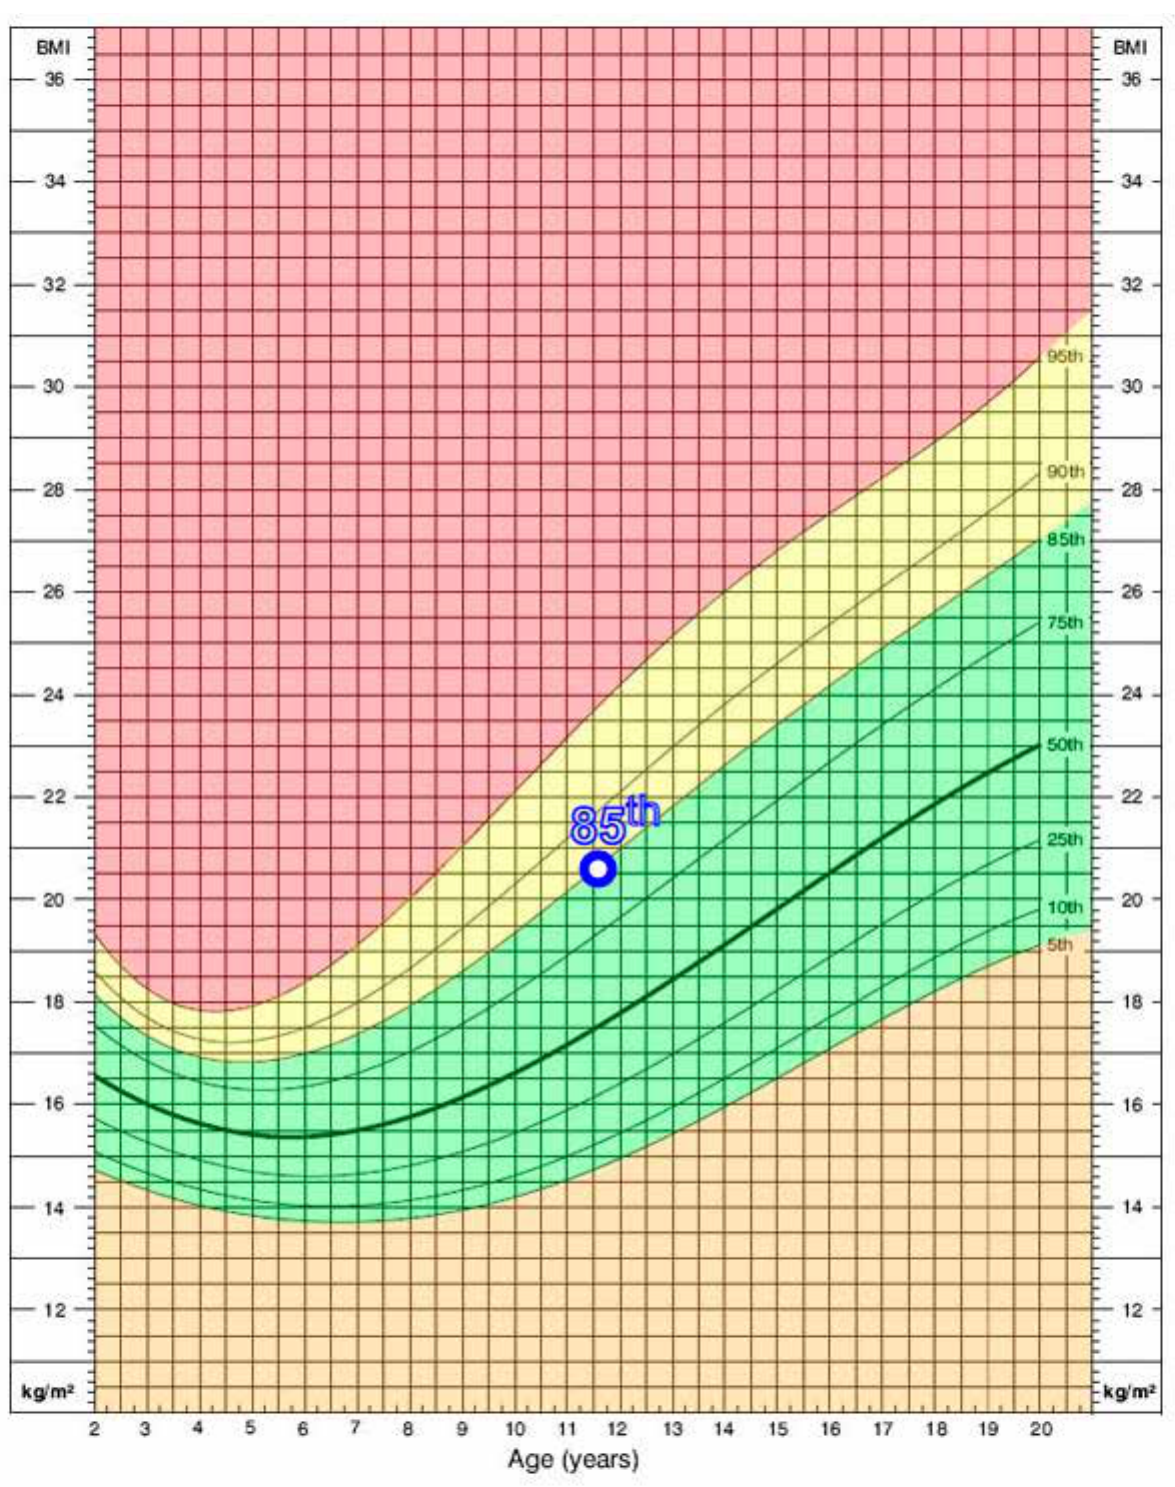
Figure 1. Percentile values of boys and development are not based on healthy habits, the risk of developing various diseases, both in youth and in adulthood, is inevitable. In our country, as in the region, every third child spends three to five hours a day in front of a computer or TV, which significantly affects weight gain [21]. Kosti, Panagiotakos [22] point to the need to take urgent measures to combat obesity that has reached